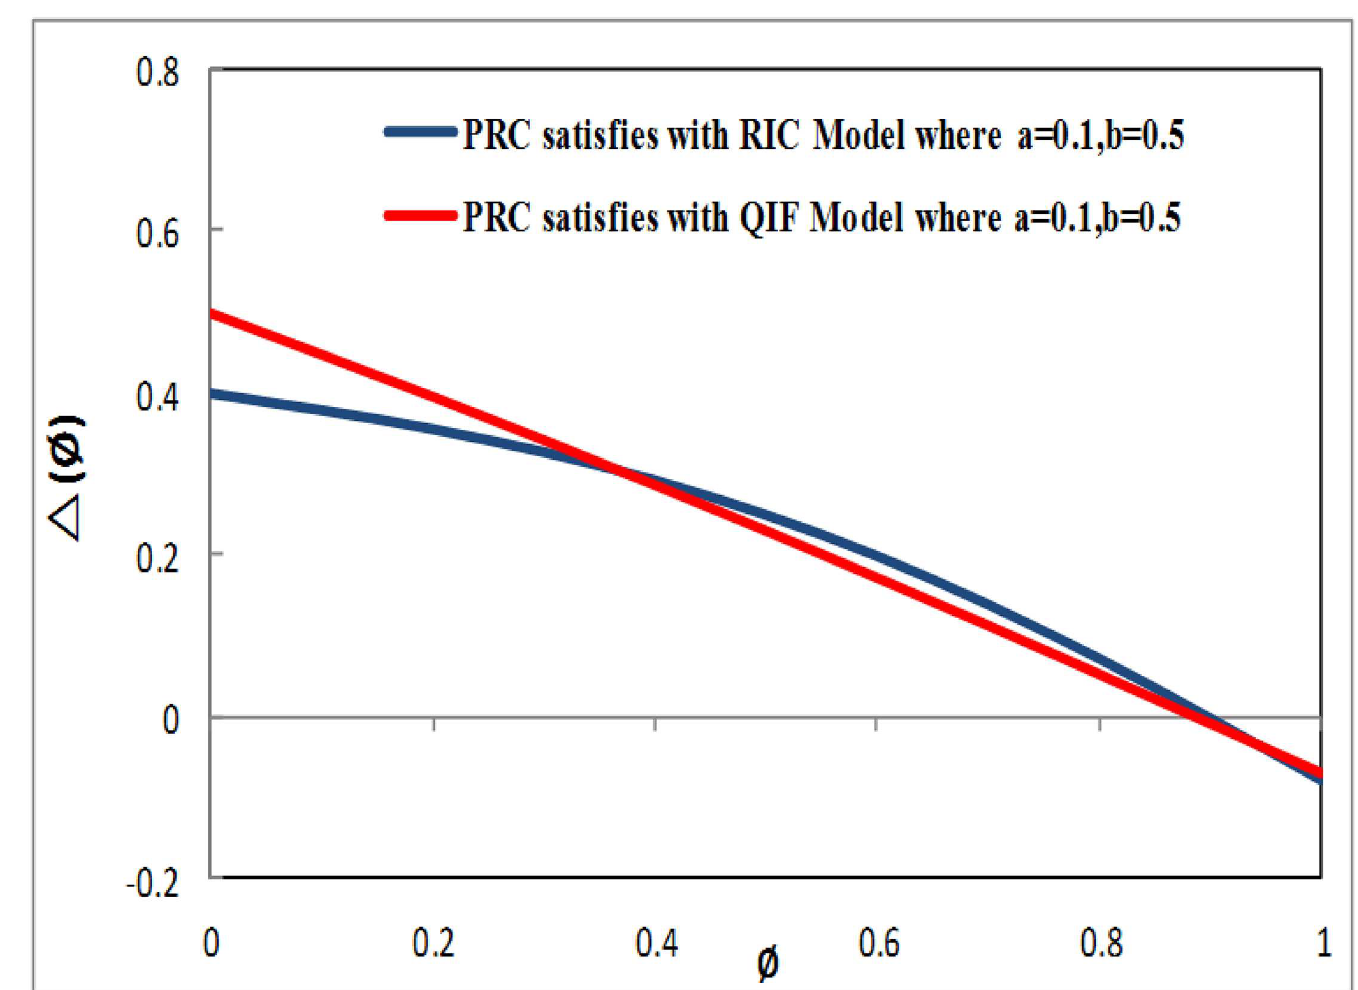
Fig 1. Evaluation of PRC ( Δ s ( ϕ )) with RIC model and QIF